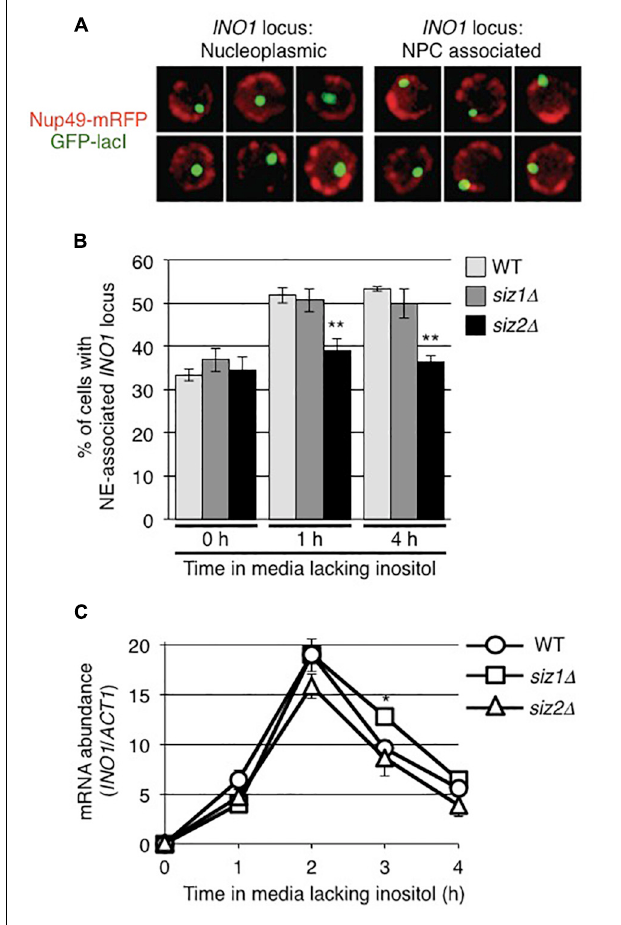
FIGURE 2 | The SUMO ligase Siz2 is required for NE-association, but not transcription, of induced INO1 . Localization of the INO1 locus prior to and following INO1 induction was examined in cells containing the INO1-lacO 256 construct and producing GFP-lacI (green). The position of the nuclear envelope (NE) in these cells relative to the INO1-lacO locus was determined using Nup49-RFP (red). (A) Examples of cell nuclei in which the INO1 locus (green) was (left panels) or was not (right panels) associated with the nuclear periphery (red) are shown. INO1 was scored to be NE-associated if the GFP-lacI signal fully or partially overlapped with the Nup49-mRFP signal. (B) The percentage of cells showing NE-association of INO1-lacO prior to (0 h) or at 1 and 4 h after induction was determined in the indicated strains. Results are the means ± SD of three biological replicates. At least 100 cells were counted for each sample. (C) Levels of INO1 mRNA were examined in the indicated strains. Cell cultures were grown in medium containing inositol (repressing conditions) to an OD 600 of ∼ 0.8 and then washed and placed in medium lacking inositol (inducing conditions) for the indicated times. Levels of mRNA encoded by the INO1 gene were evaluated by qRT-PCR and their abundance relative to ACT1 mRNA was determined. Results are the means ± SEM of three biological replicates. Asterisks indicate a significant difference from WT as indicated by Student’s unpaired t -test, * p < 0.05, ** p <